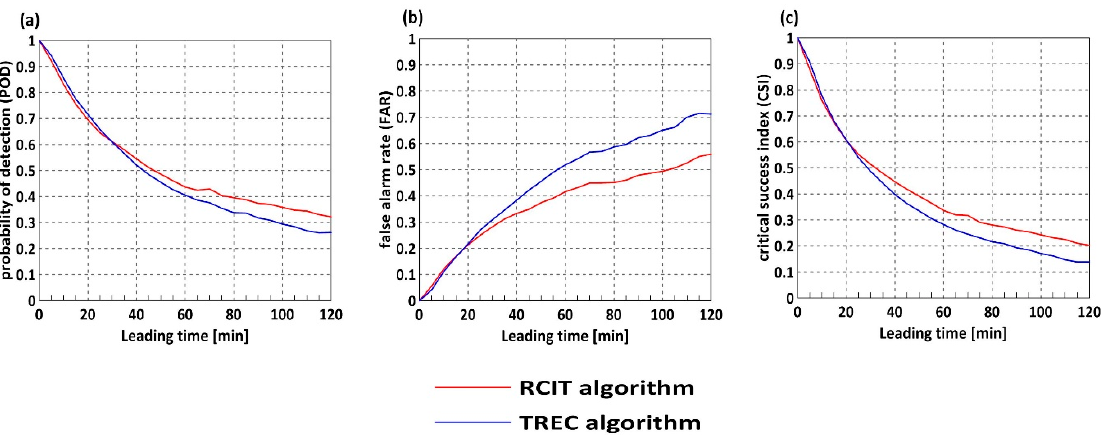
Figure 10. Averaged value of three contingency table skill scores for forecasting results by two tracking algorithms. ( a ) POD; ( b ) FAR; ( c ) CSI. The red solid lines in each subplot represent results for the RCIT algorithm, the blue solid lines represent results for the TREC algorithm.